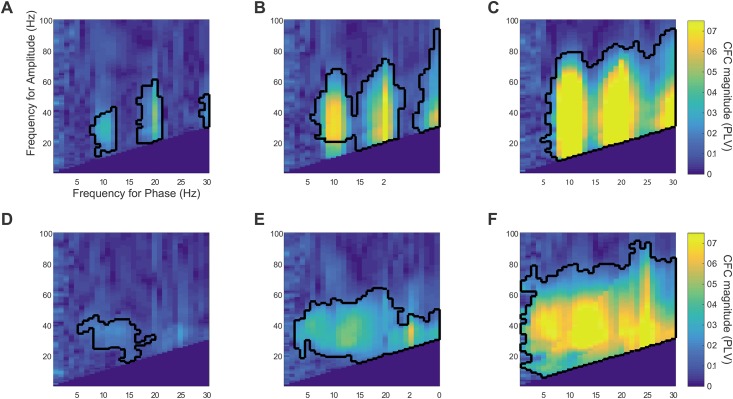
CFC for periodic vs. non-periodic spike trains.A-C. phase-amplitude comodulograms for semi-periodic sharp waveforms (100 ms mean interval, 10 ms jitter, 15 ms Gaussian spike width). The spike amplitude is set to 1, 2, or 5 standard deviation of the background signal from the left (A) to the right (C) panel. Clusters of significant CFC in the comodulograms are marked with a black outline (p<0.01). D-F. The same comodulograms for a non-periodic signal. It can be seen that in the absence of periodicity, the CFC effect occurs on a wider range of frequencies-for-phase, and the CFC magnitude is smaller.